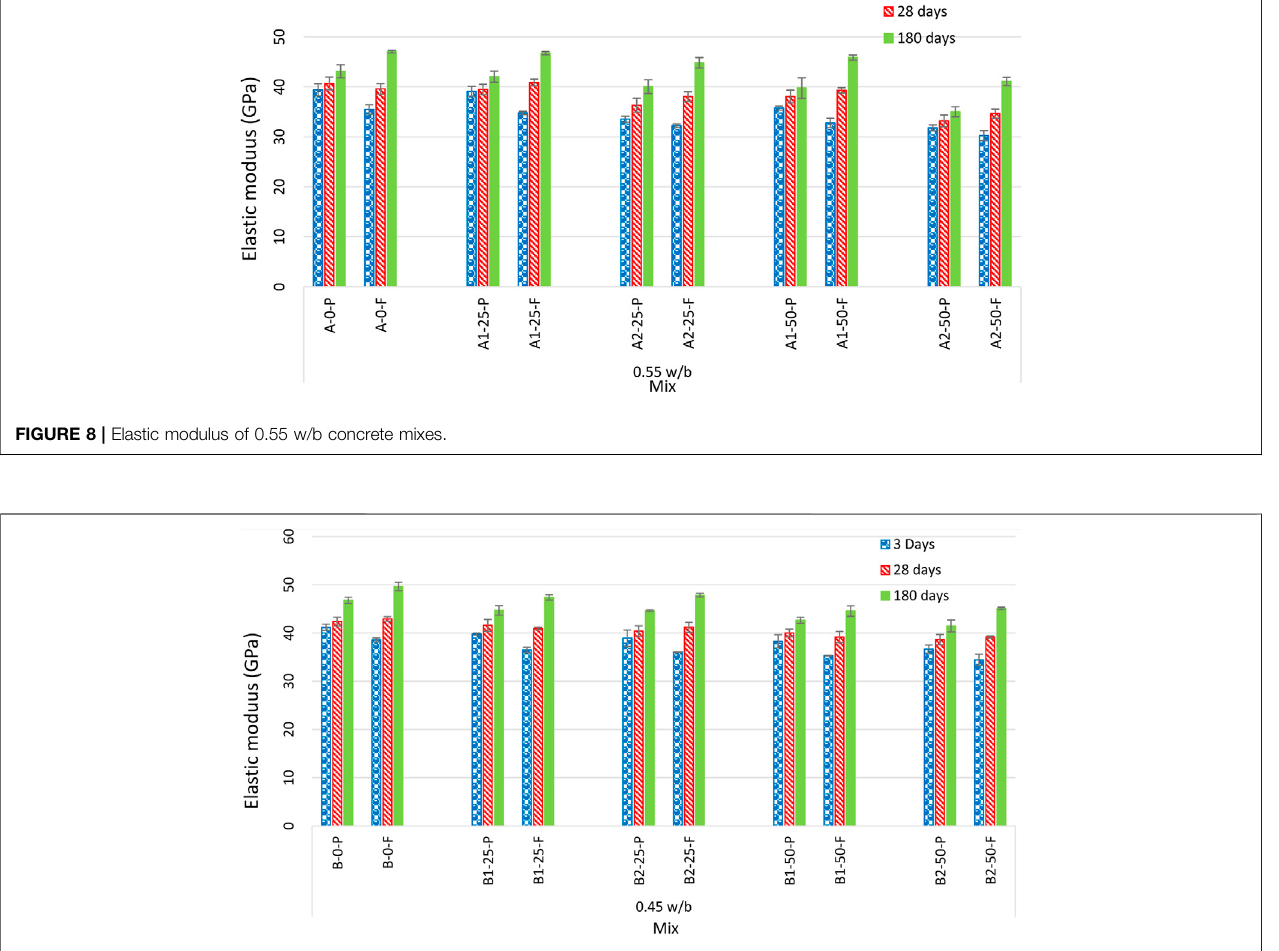
FIGURE 9 | Elastic modulus 0.45 w/b concrete